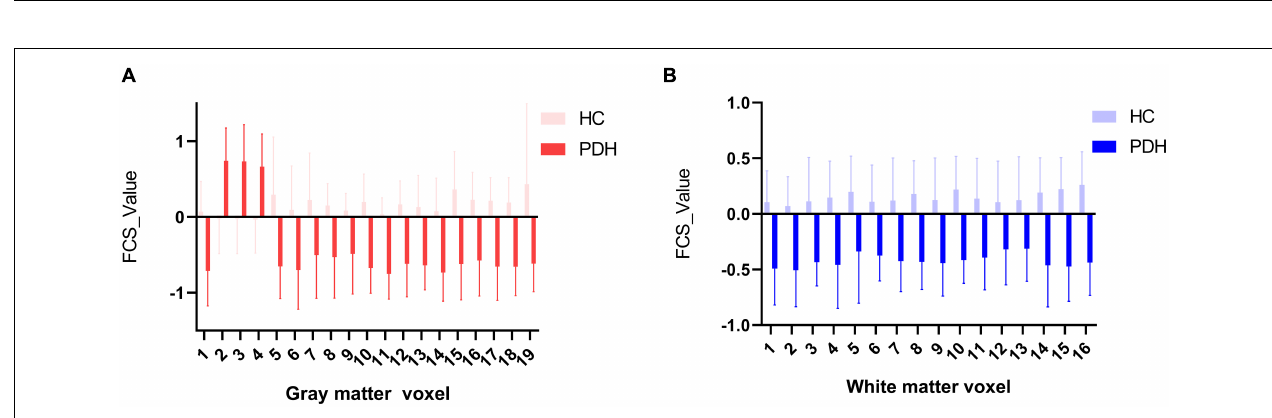
FIGURE 4 | The white matter areas in abnormal functional covariance connections. Areas marked in blue are brain white matter areas where FCS is statistically different between the PDH and HC groups (two sample t -test, p < 0.05, FDR correction).